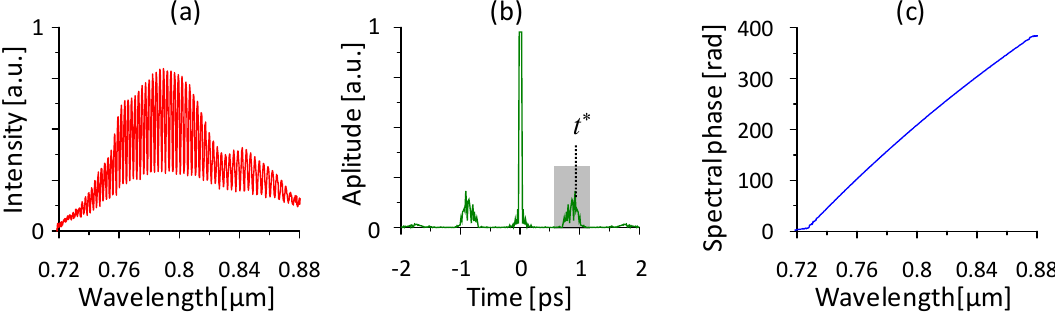
Figure 9. Steps of the spectral phase calculation by Fourier-transform SRI . The recorded interferogram ( a ) is inverse Fourier-transformed to time domain, and filtered ( b ). Finally, the remainder is transformed back to spectral domain. The complex angle corresponds to the spectral phase difference between the arms of the interferometer ( c